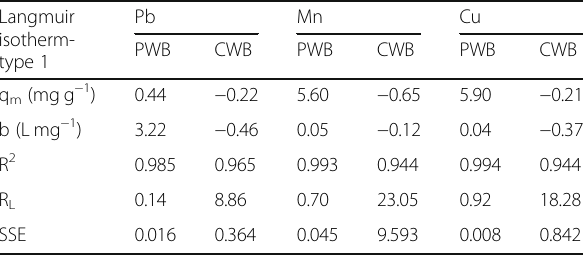
Table 3 Parameters of the Langmuir isotherm for adsorption of Pb, Mn and Cu onto BC in landfill leachate Langmuir isotherm- type